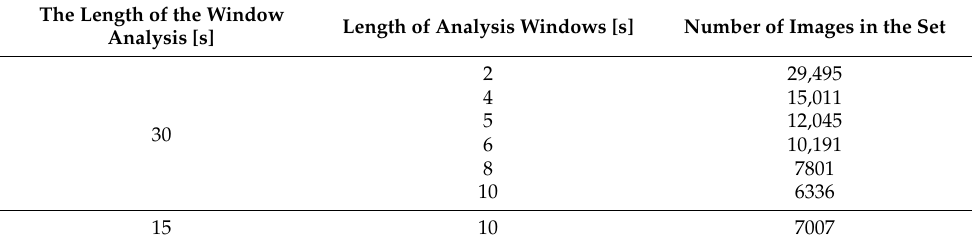
Table 3. Parameters of the generated